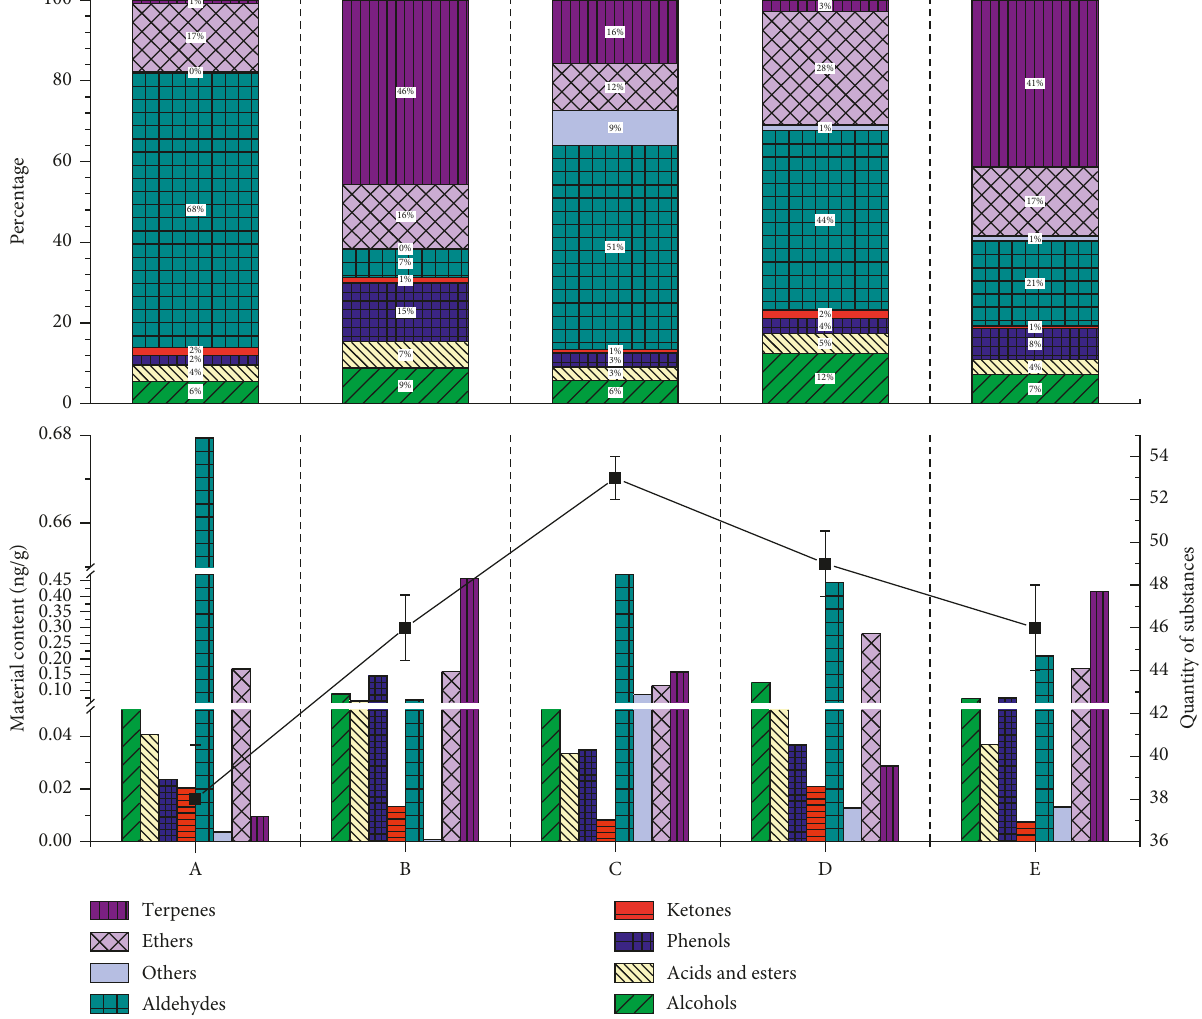
Figure 1: Relative percentage content, standard deviations ( n � 3 samples and triplicate analysis), and quantity of substance of free aroma compounds of roasted mutton obtained in independent experiments with four kinds of spices (sample A, only salt; sample B, Chinese prickly ash; sample C, Amomum tsao-ko ; sample D, cumin; sample E, ginger). Different colors indicate different compound classes, and the area size of the rectangle is different due to different